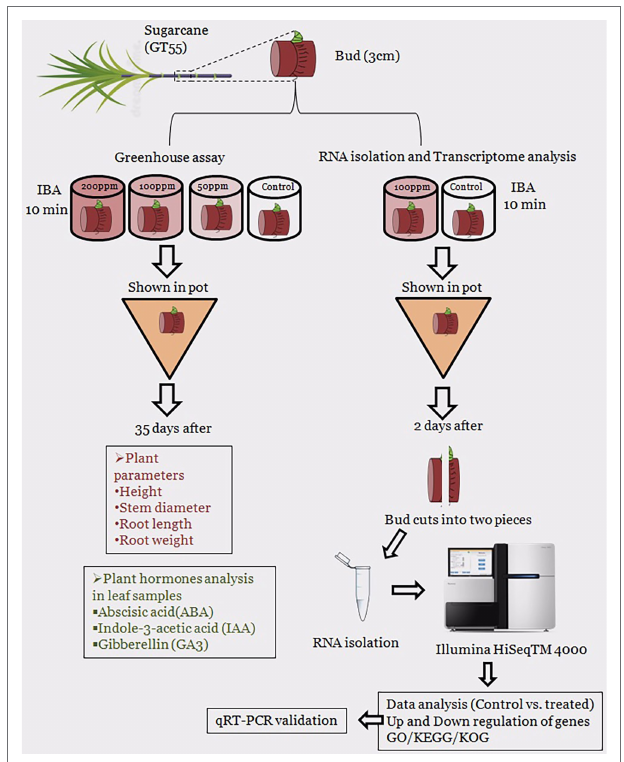
FIGURE 1 | Schematic diagram of an overall research experiment that used in the current